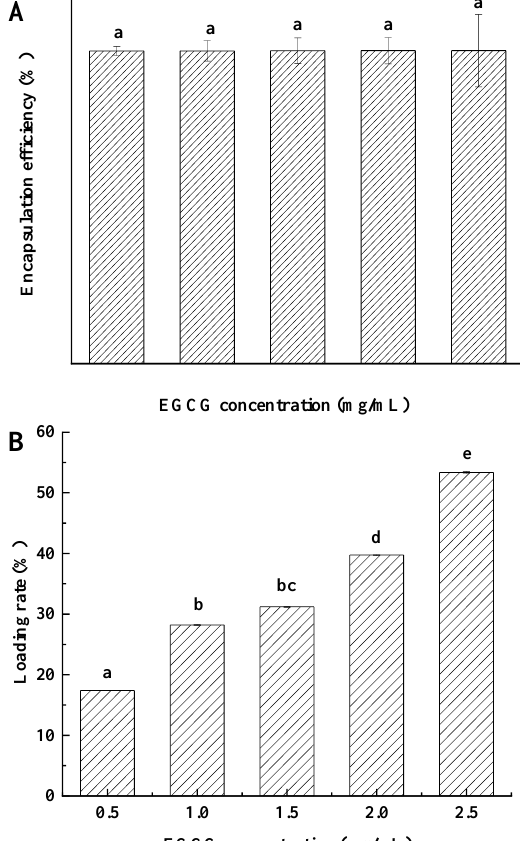
Figure 4. Encapsulation efficiency ( A ) and loading rate ( B ) of BPENs. Histograms followed by different letters were significantly different at p < 0.05.